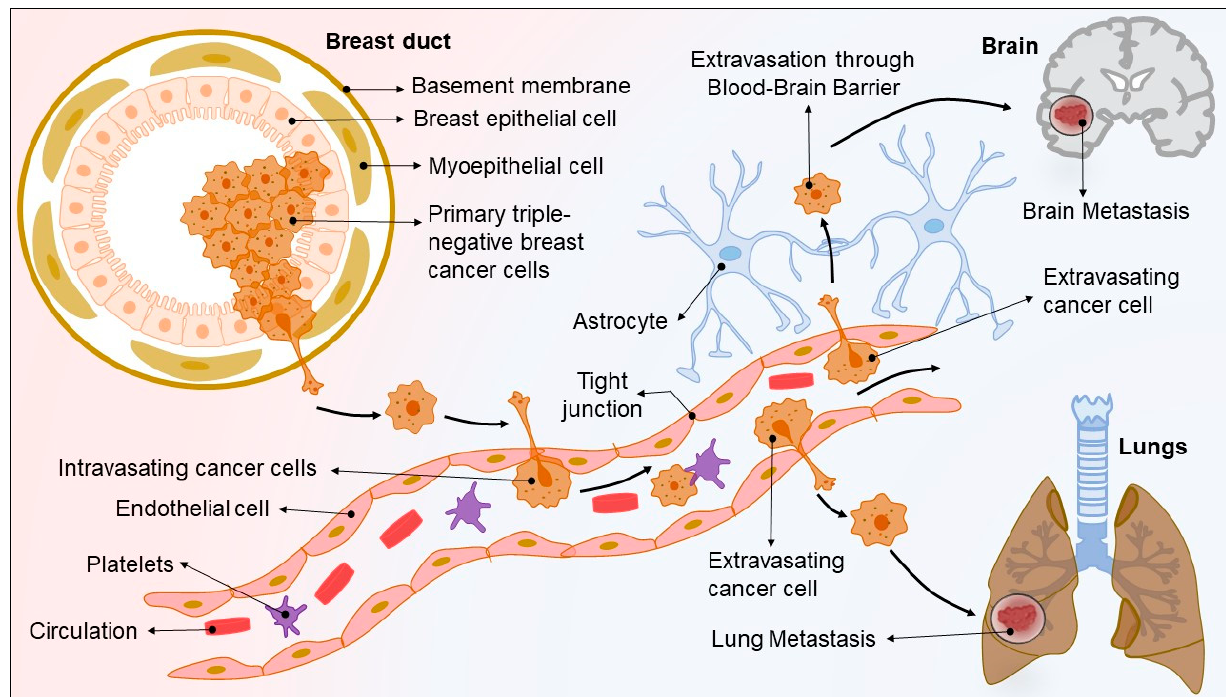
Figure 1. TNBC metastasis: Upon local invasion and intravasation, the TNBC cells experience various physiological changes like activation of EMT, MMPs, and pro-migratory signaling pathways, which enable the tumor cells to enter the circulation. After entering the systemic circulation, the tumor cells interact with platelets, which trigger the pro-survival pathways and restrict various apoptotic signaling pathways. The migrated tumor cells then extravasate via endothelial blood vessels and reach the secondary organs like the brain, bone, and lungs, where they get activated by metastasis-colonizing genes that allow them to enter a state of macrometastatic outgrowth [15].